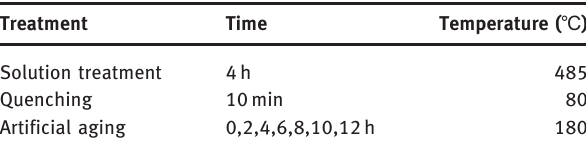
Table 2: Heat treatment conditions of Al-Si-Cu-Mg alloy.